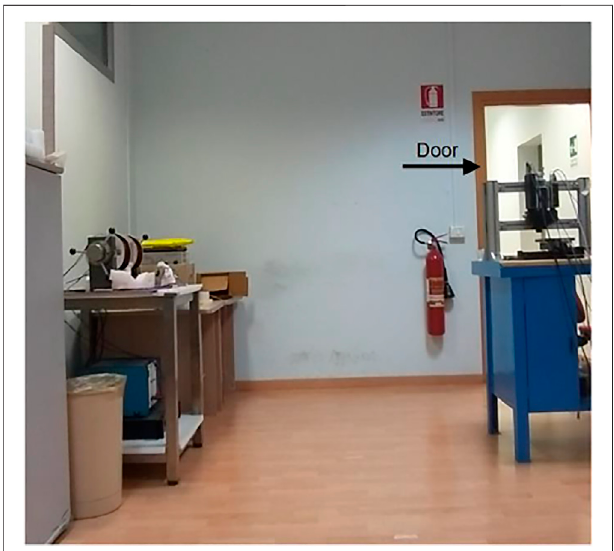
Figure 7 . The spectrograms are determined by plotting the short-time Fourier transforms of the signal over time windows having duration of 3 s and overlap of 2.9 s. As can be observed, the Doppler band is essentially null in the case of empty scene ( Figure 8A ). When a static target is present at 3 m distance ( Figure 8B ), it is possible to notice a slight increase in the amplitude of some spectral components around the typical frequencies of respiratory activity (0.2 – 0.4 Hz) (Cerasuolo et al., 2017). Finally, if the person walks around ( Figure 8C ), the spectrum has a signi fi cant amplitude at different frequencies.